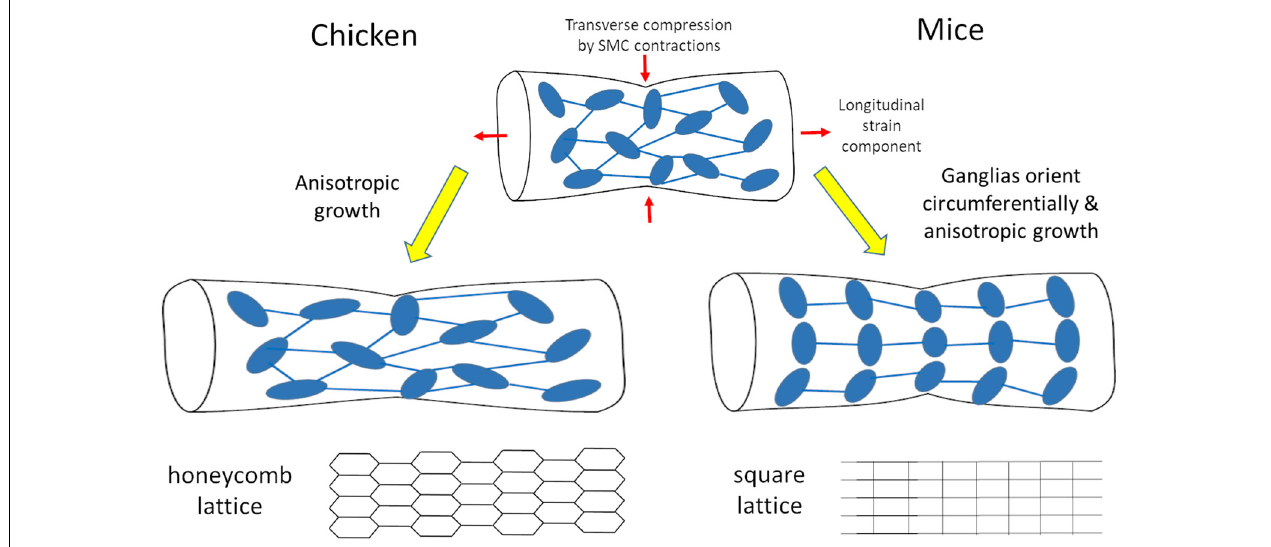
FIGURE 6 | Scheme of morphogenesis routes for the chicken and mouse enteric nervous system resulting respectively in honeycomb and square